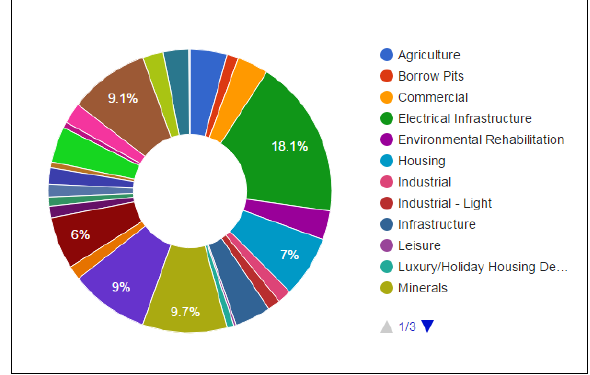
Figure 3: Development reporting in the national inventory (SAHRA,